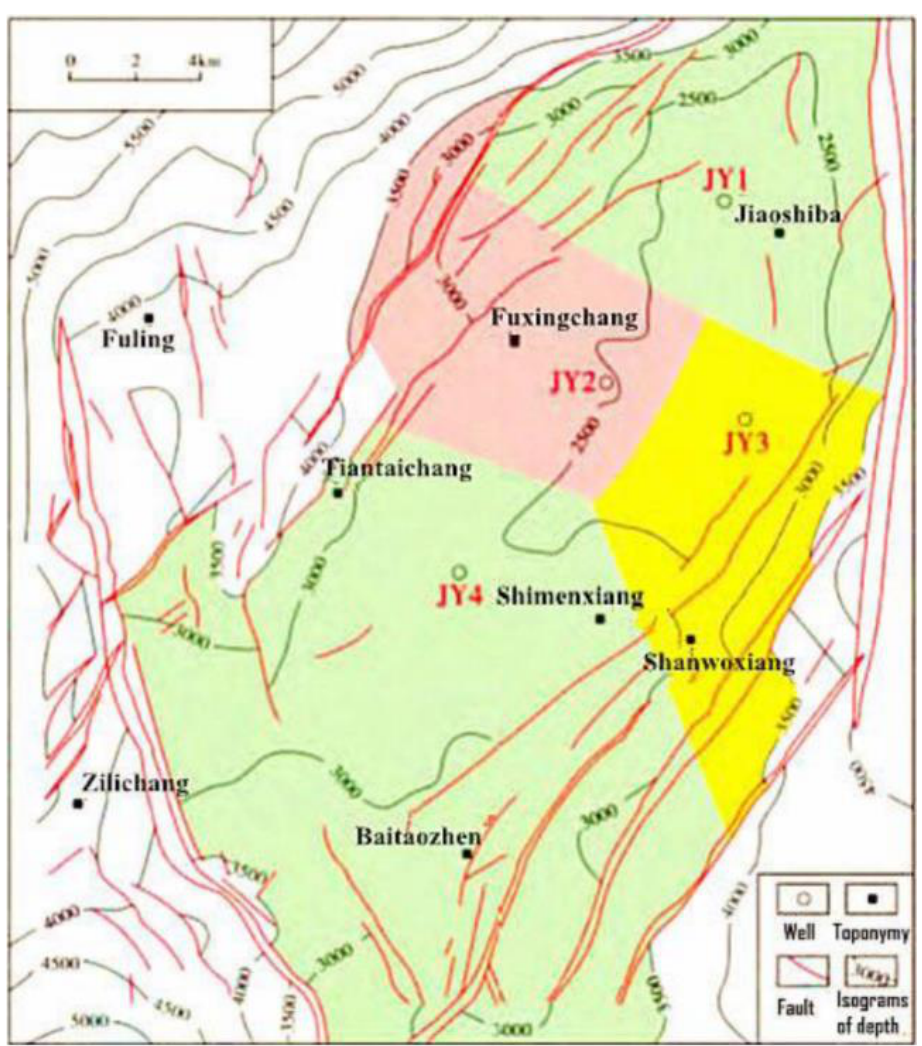
Figure 1. The main district of the Fuling shale gas field.